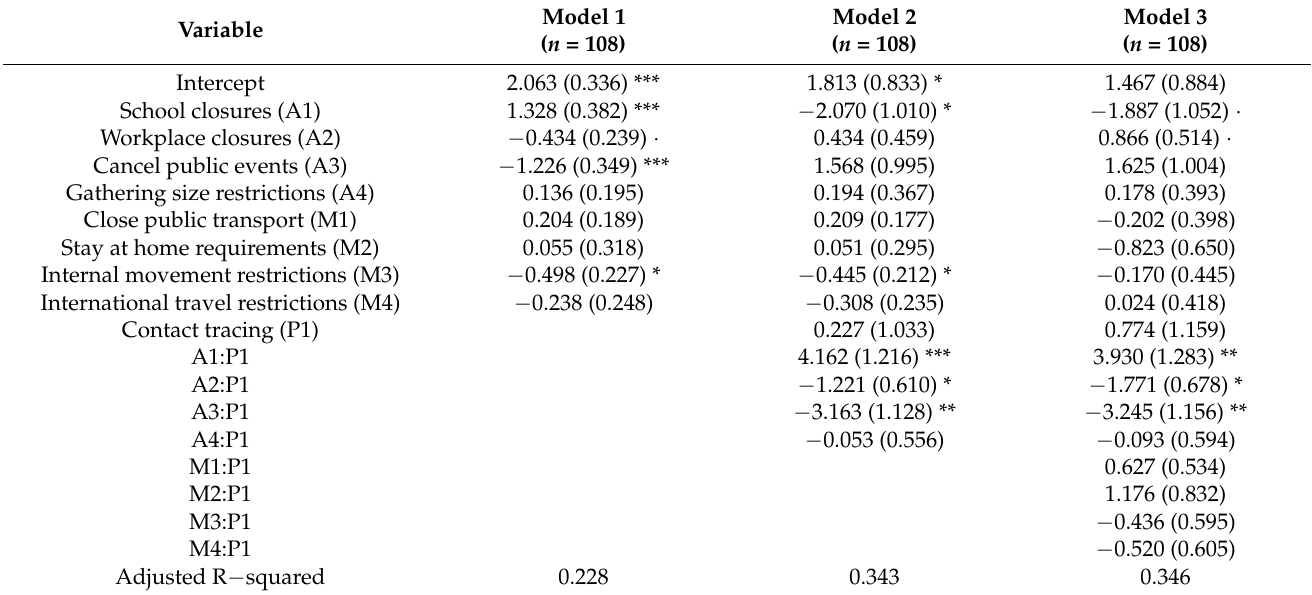
Table 4. Regression results by